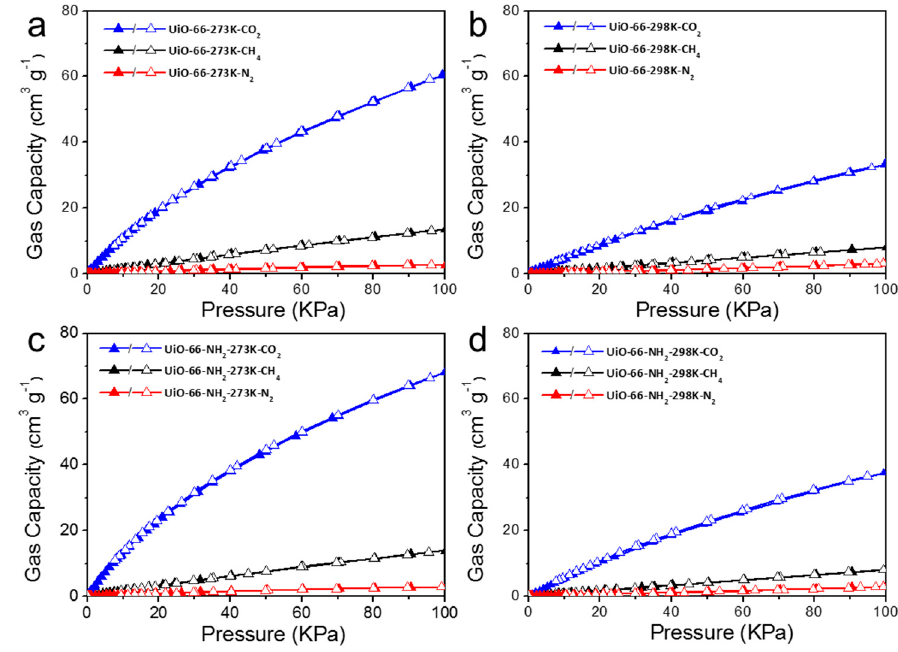
Figure 4. CO 2 , CH 4 , and N 2 adsorption–desorption isotherms of UiO-66 at 273K ( a ) and 298K ( b ); UiO-66-NH 2 at 273 K ( c ) and 298 K ( d ).